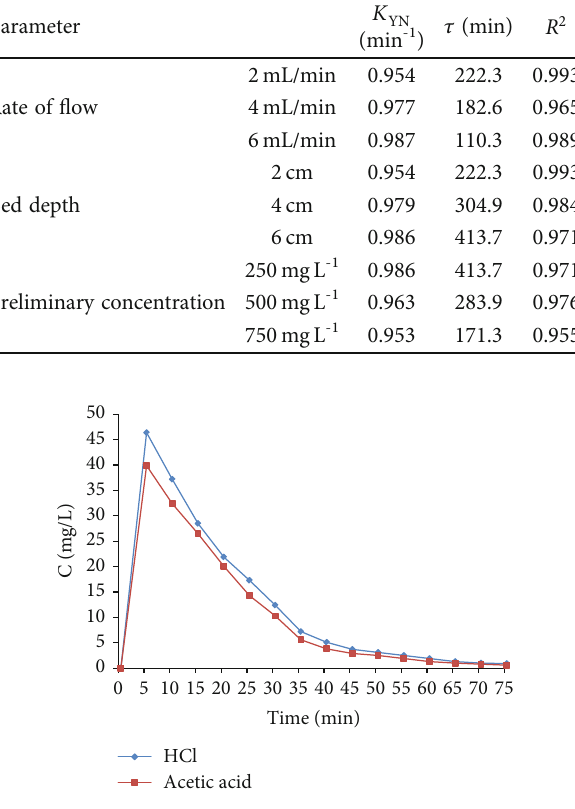
Figure 5: Desorption curves of lead ions with respect to time from ZSM-5/AC.